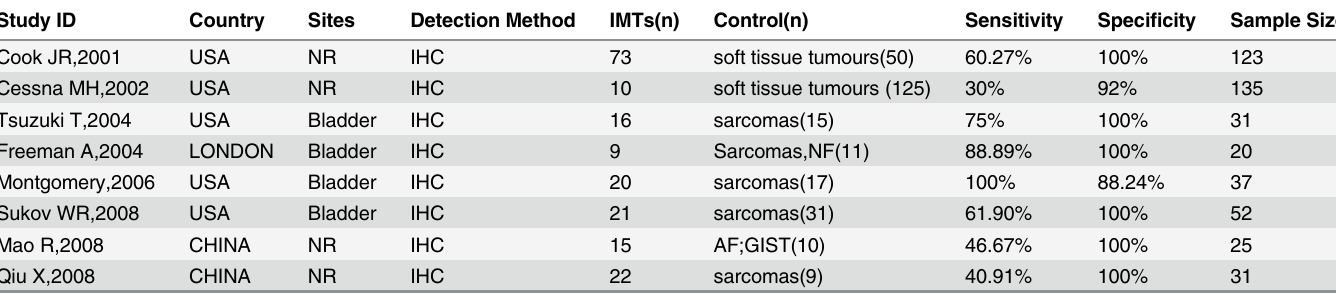
Table 1. Characteristics and quality assessment of the included ALK